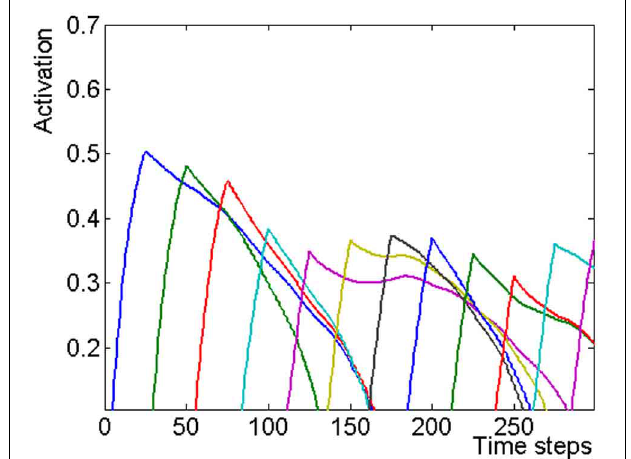
FIGURE 5 | The dynamics of the lexical layer during a 12 items list simulation. The activation of each item is shown as a different color graph. It can be seen that the first three activated items reach higher activation values, because they face less competition from previously presented